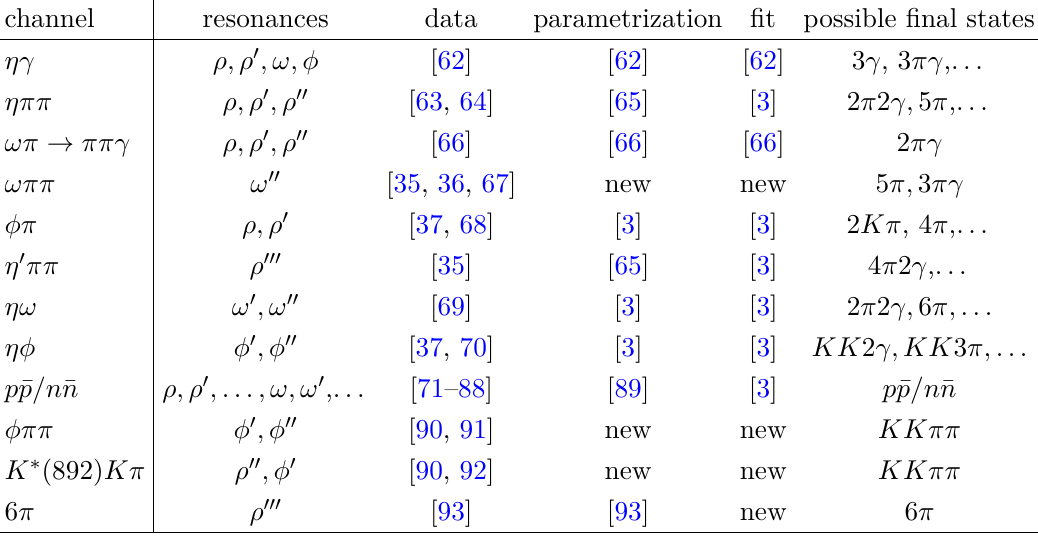
Table 3 . Additional processes included in this work that are not present in the